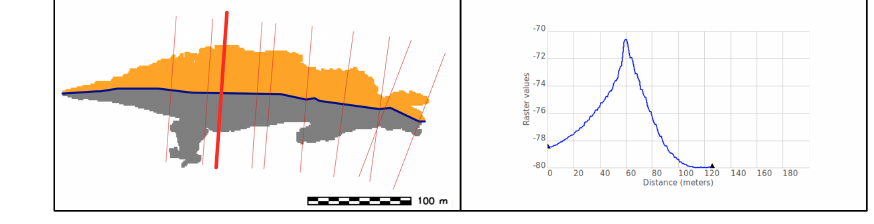
Figure 24. SW height.